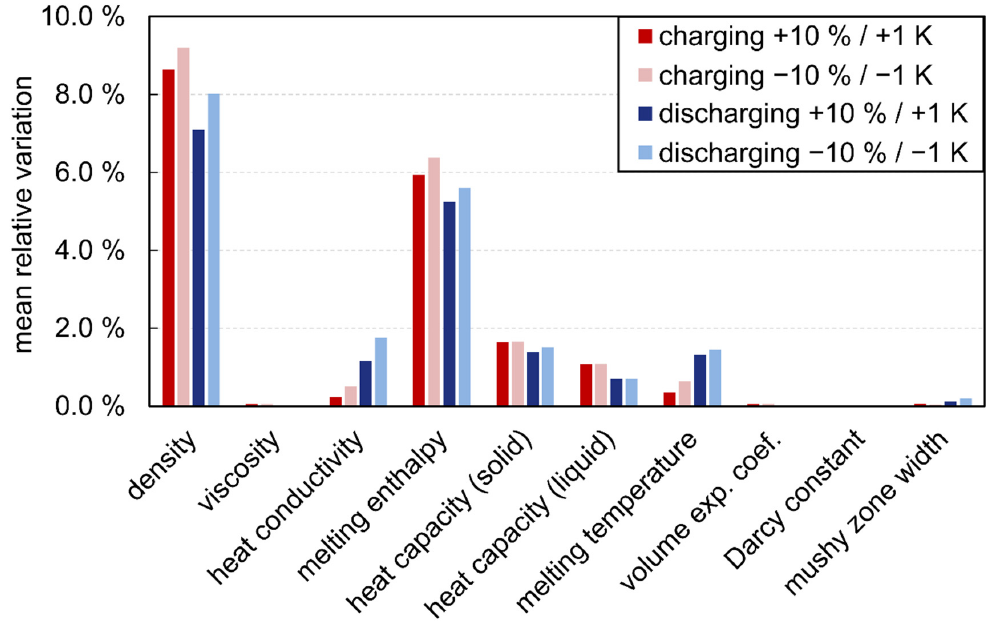
Figure 6. Absolute relative variation of the mean power for charging and discharging when varying the material properties by ± 10% or ± 1 K.